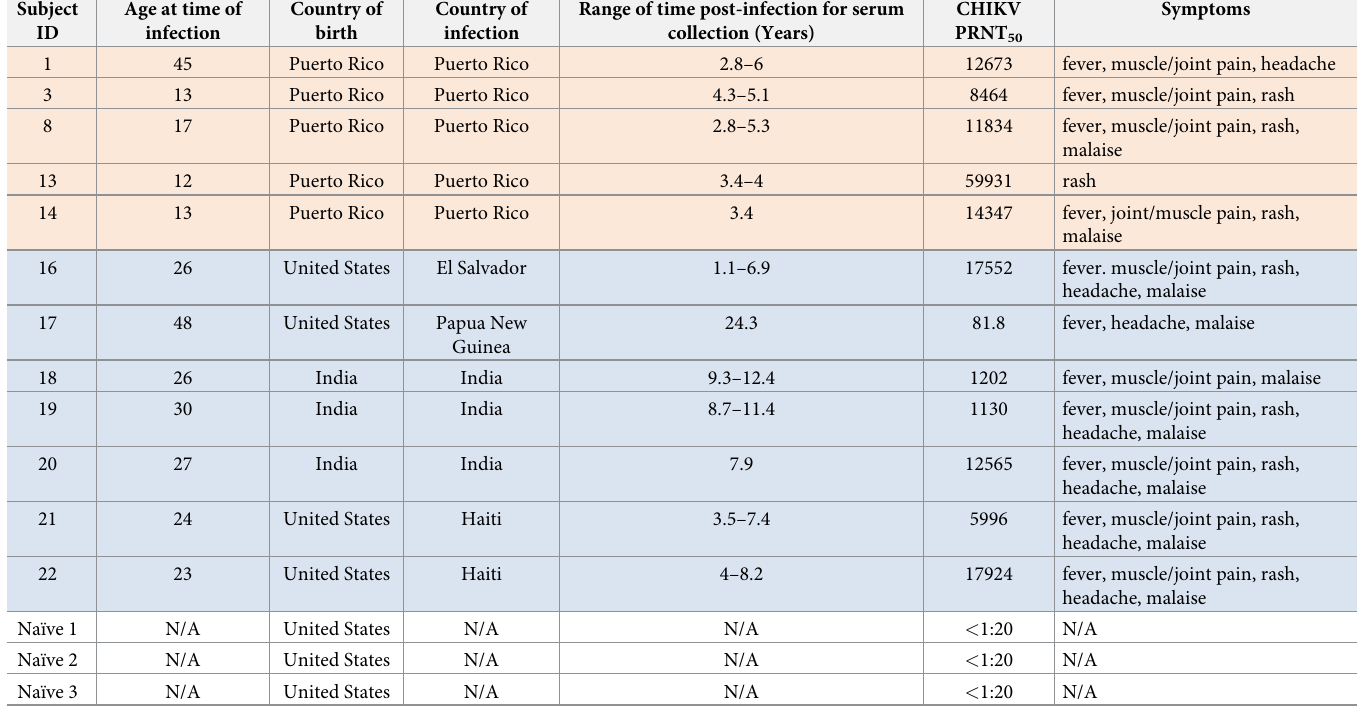
Table 1. Summary of subject data. Subjects with confirmed or suspected CHIKV infection were enrolled in either an endemic cohort (Ponce, Puerto Rico; color coded in orange), a non-endemic cohort (Portland, Oregon; color coded in blue), or an alphavirus na ï ve cohort (Portland, Oregon; color coded in black). Subjects are assigned an ID with age, country of birth, country of infection, range of time-post infection for serum collection, CHIKV PRNT 50 at time of primary blood draw, and reported symptoms